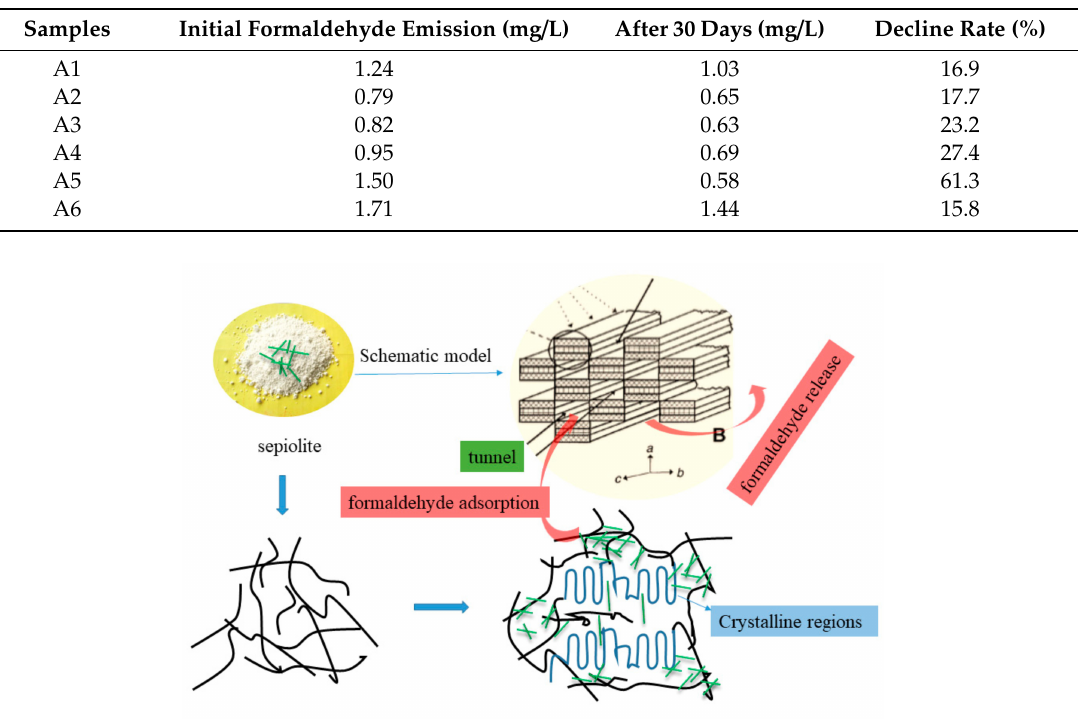
Table 2. The comparison of the plywood initial formaldehyde emission and the values after 30 days.